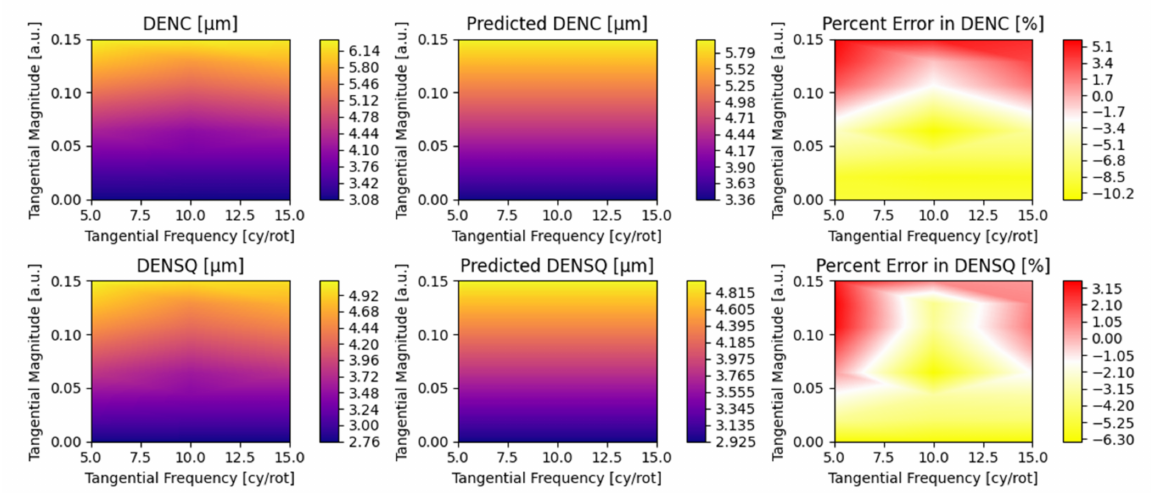
Figure A17. Tangential Frequency vs. tangential magnitude. ( η = ζ = δ = 0, ξ = 15, σ = 0.05, θ = 0 ◦ ).